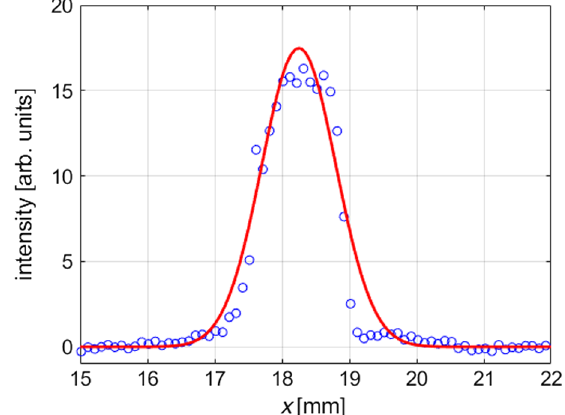
FIG. 5. The laser beam profile measured using the wire scanner and PMT arrangement.